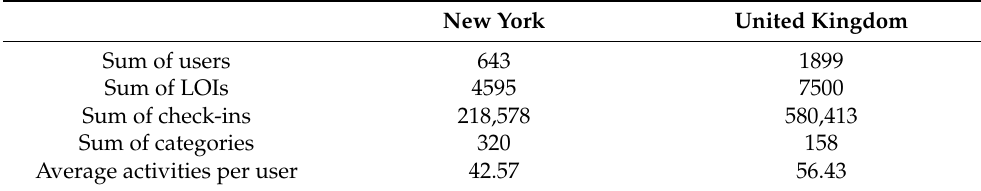
Table 2. Statistics of